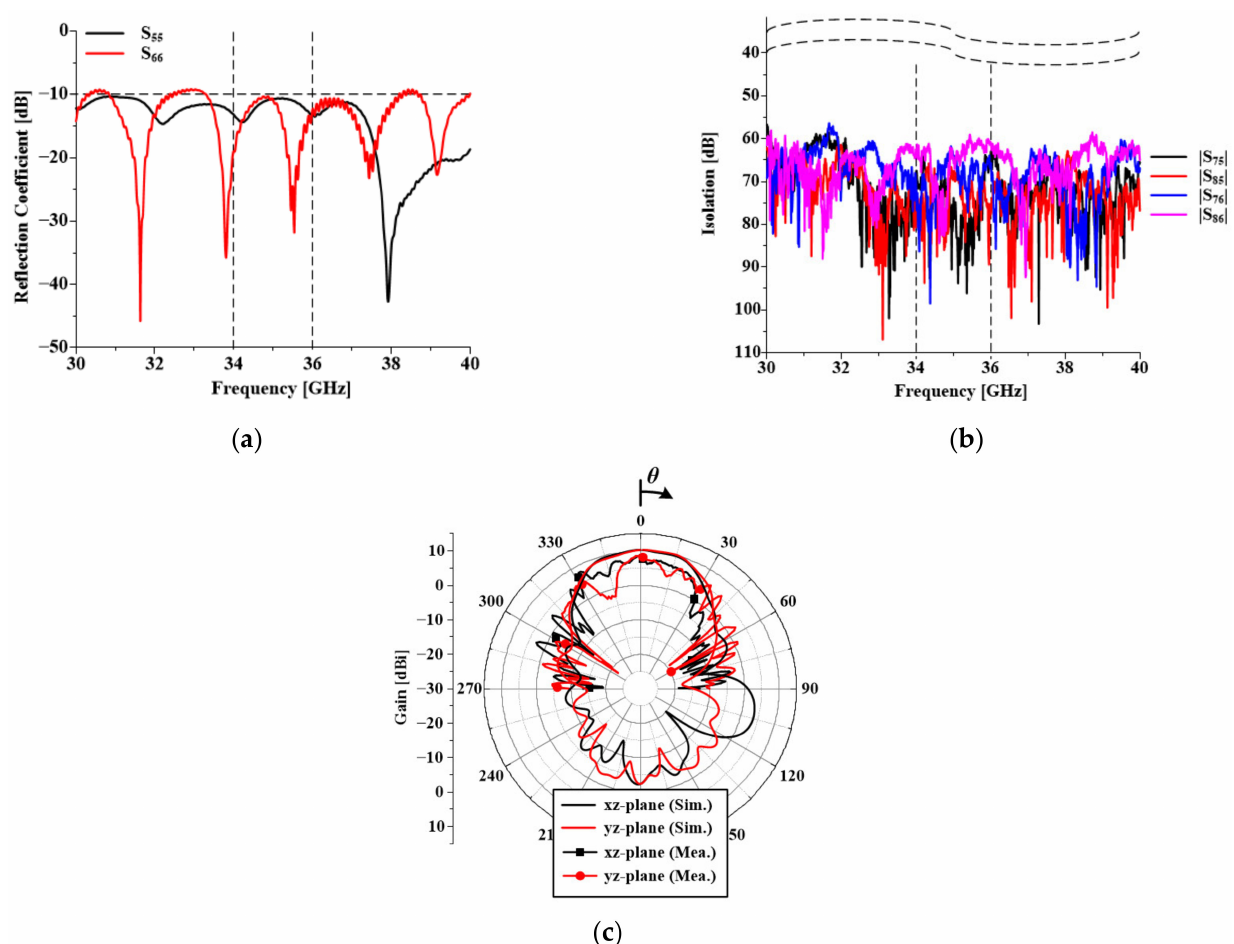
Figure 18. Measured results of Ka-band patch antenna array: ( a ) measured reflection coefficient performances of Ports 5 and 6, ( b ) measured isolation characteristics between Tx/Rx Ka-band patch antenna arrays, and ( c ) simulated and measured radiation patterns at 35 GHz when Port 5 is